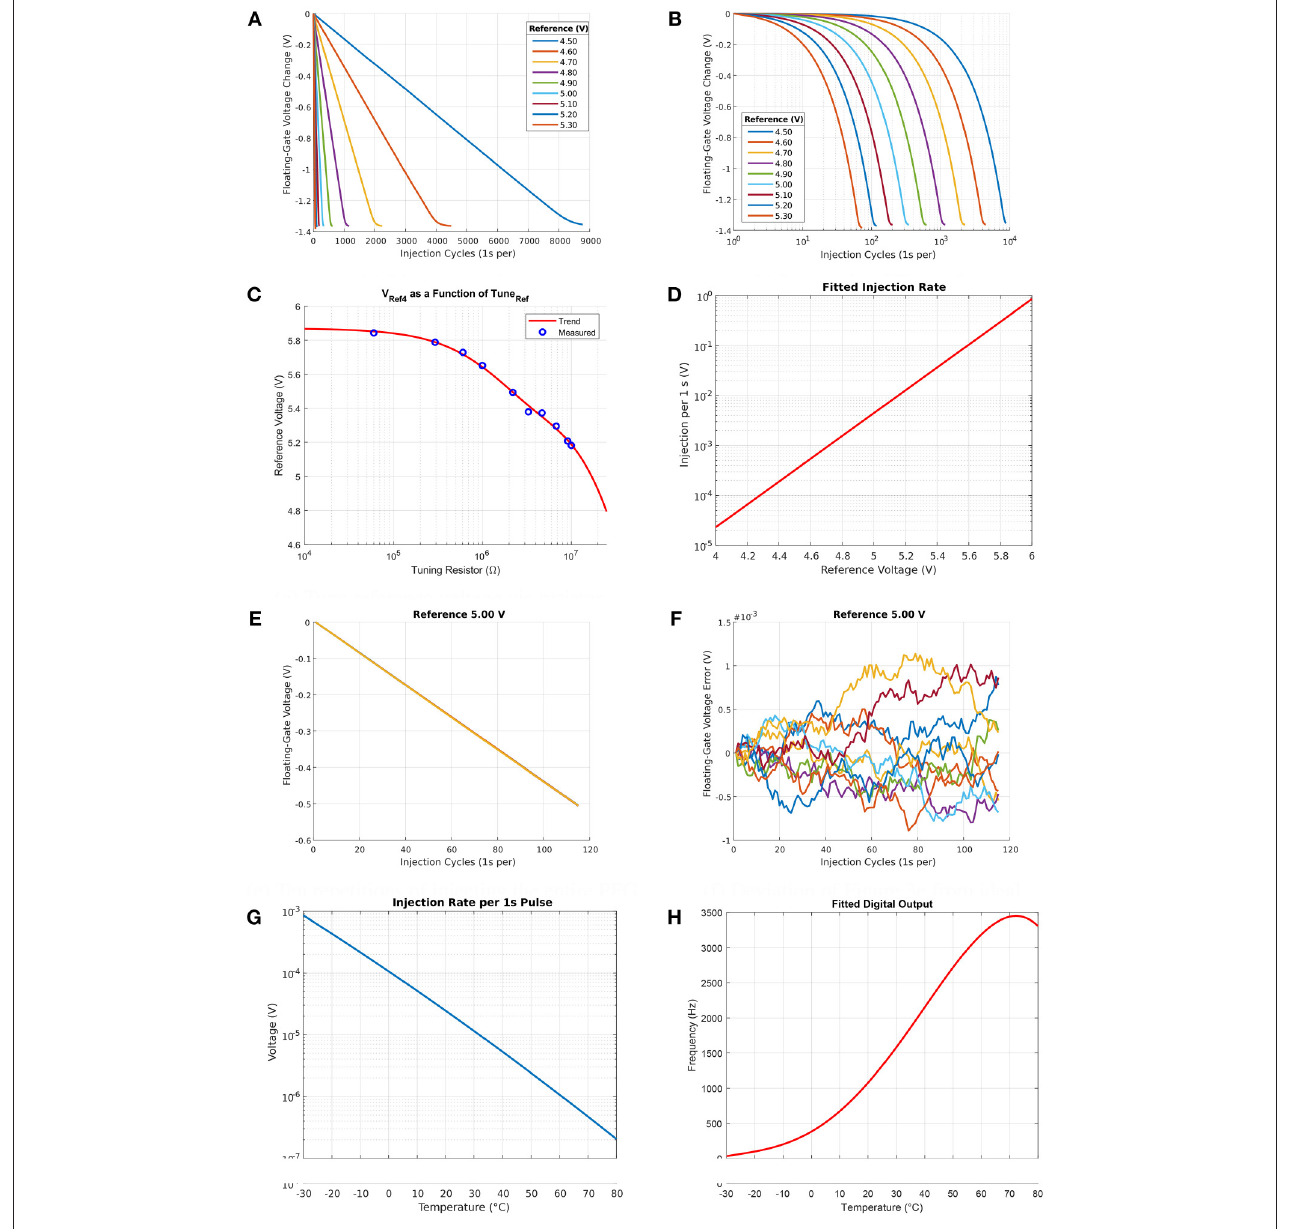
FIGURE 3 | Laboratory verification and characterization of PFG sensor functionality. (A) Linear injection, (B) Log-scale of (A) , (C) Tune reference voltage via resistor, (D) Tune injection rate via reference voltage, (E) Ten repetitions of injecting the entire PFG, (F) Deviation of (E) from ideal, (G) Temperature dependence of injection rate, and (H) Temperature dependence of